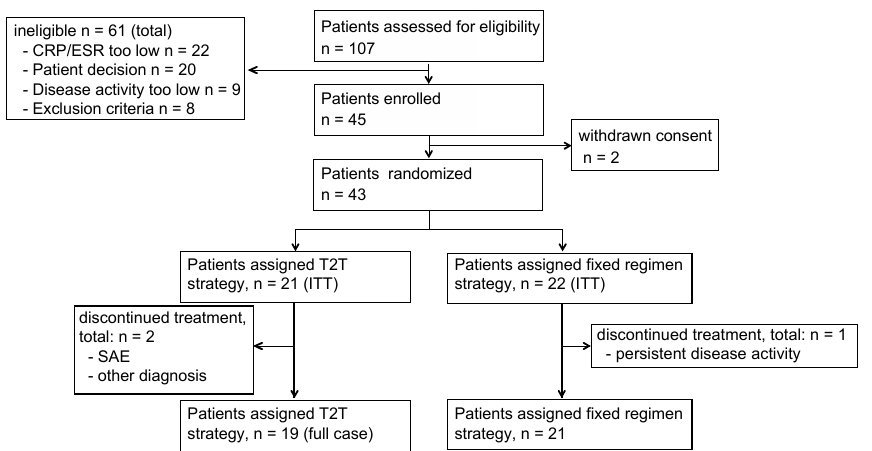
Figure 2. Patient disposition: T2T: treat-to-target, ITT: intention to treat, ESR: erythrocyte sedimentation rate, CRP: C reactive protein, SAE: serious adverse event.